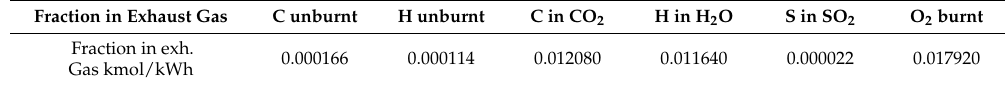
Table 7. The share of the components involved in the combustion.